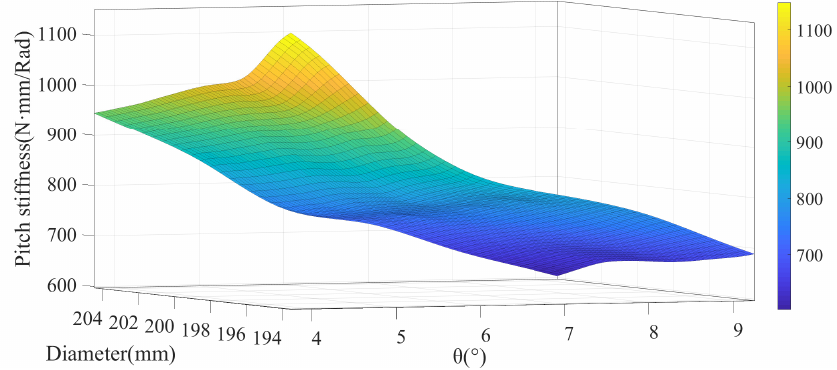
Figure 18. Influence of geometric parameters of bistable mechanism on pitch